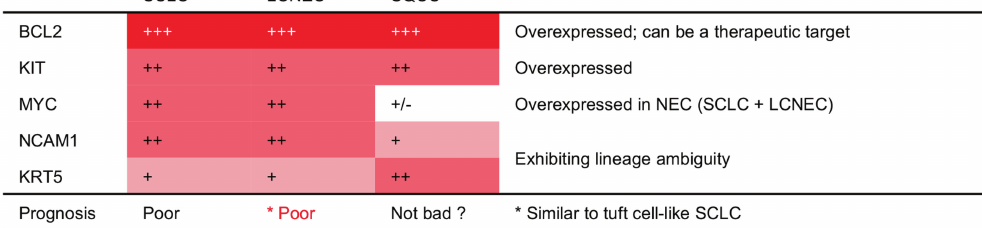
Consistent with our protein expression analyses, data from the public datasets [24, 27] con fi rmed “ lineage ambiguities ” : In both tuft cell-like SCLC and LCNEC, KRT5 mRNA expression levels were signi fi cantly higher (Fig. 3A), while expression levels of speci fi c neuroendocrine markers ( CHGA , SYP , and INSM1 ), and